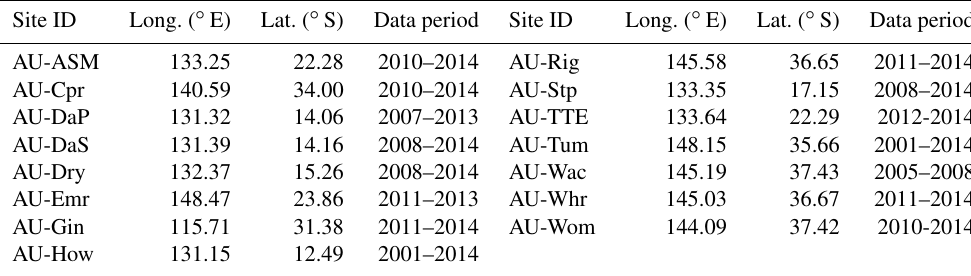
Figure 1. Spatial distributions of (a) the reciprocals of aridity index and (b) the mean annual ET a for 1998–2014 predicted by the CR with α e = 1 . 15. The red circles and the gray polygons are the locations of 15 flux towers and the boundaries of 71 CAMELS basins. The blue- colored points in (a) indicate the wet cells with RH > 90% and T ws > T a + 2 ◦ C. CR ET a was calculated at the grid cells where the land fraction was larger than 50%. Table 1. List of the chosen FLUXNET2015